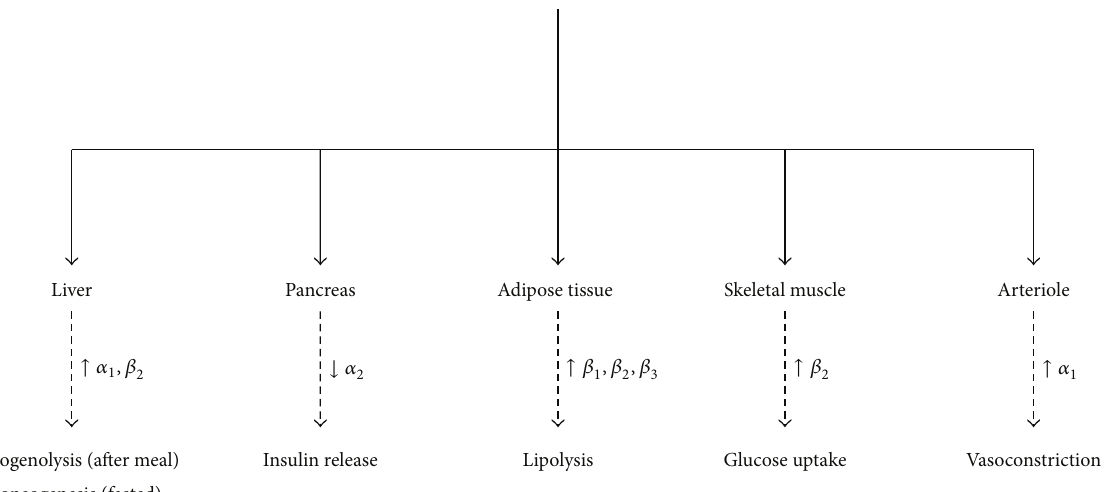
Figure 1: Role of the central sympathetic nervous system in metabolic